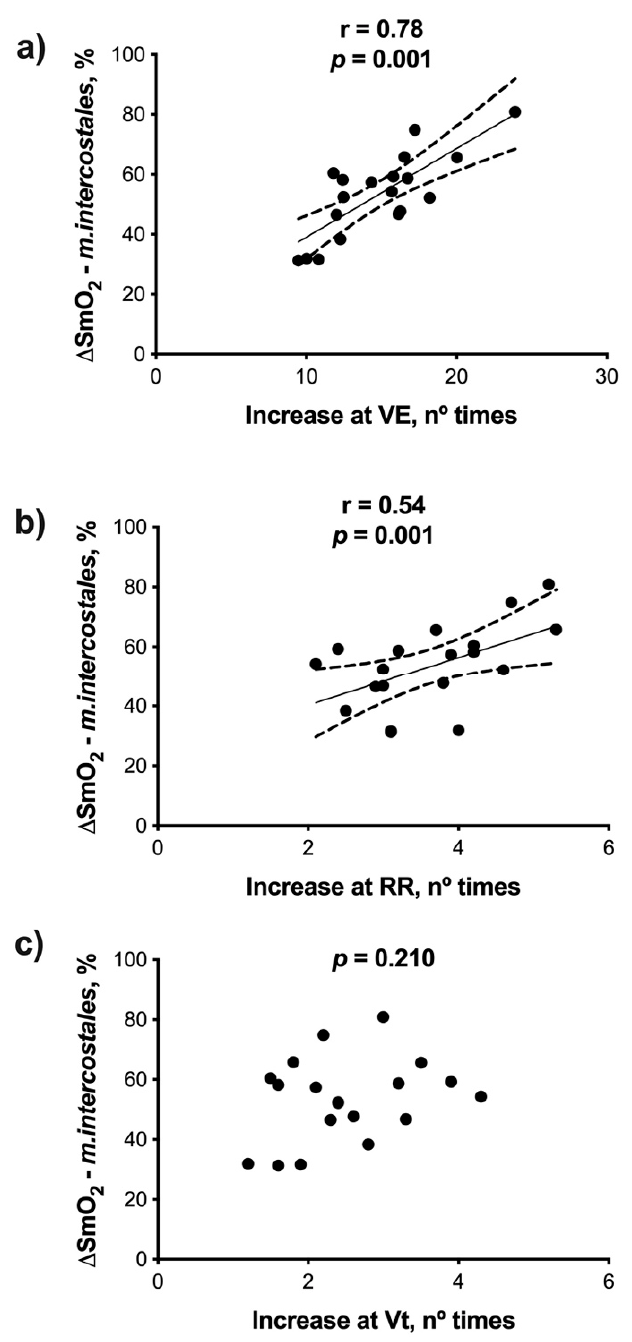
. VE (lung ventila-